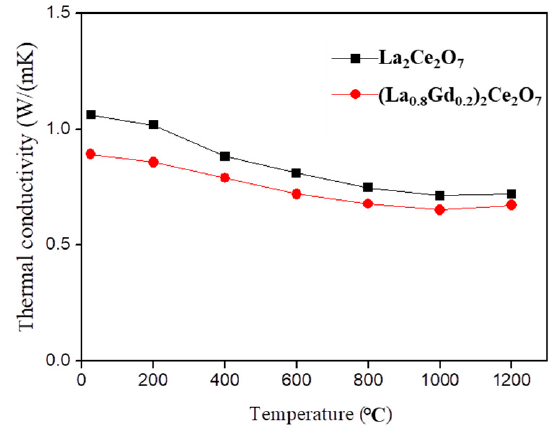
Figure 9. Thermal diffusivity values of the LC and LGC coatings.